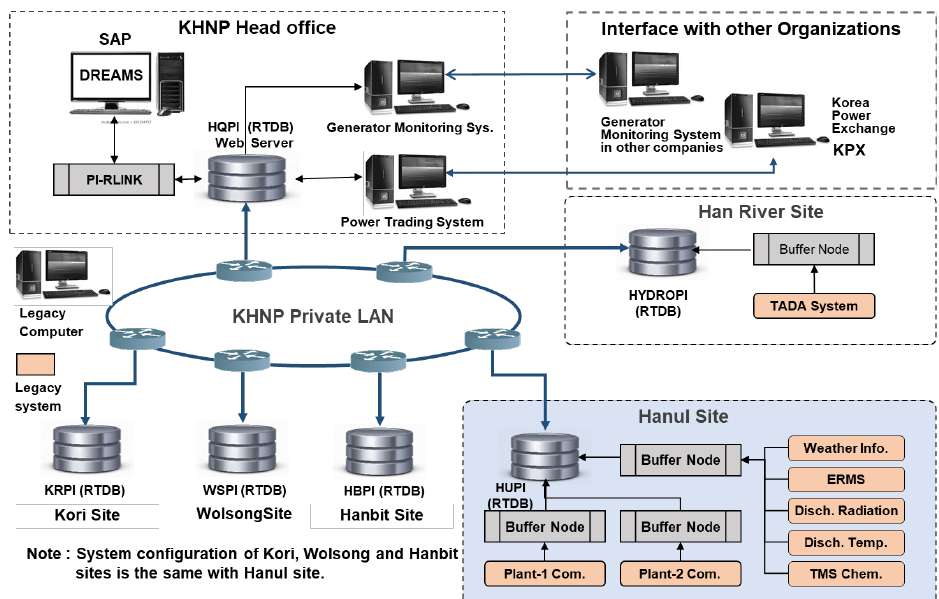
Figure 1. KHNP digital real-time enterprise asset management system (DREAMS) layout. PI: plant information, TMS: tele monitoring system, ERMS: environmental radiation management system, PM: plant maintenance, RTDB: real time data base, TADA: technical advisory and data acquisition, KHNP: Korea hydro and nuclear power .